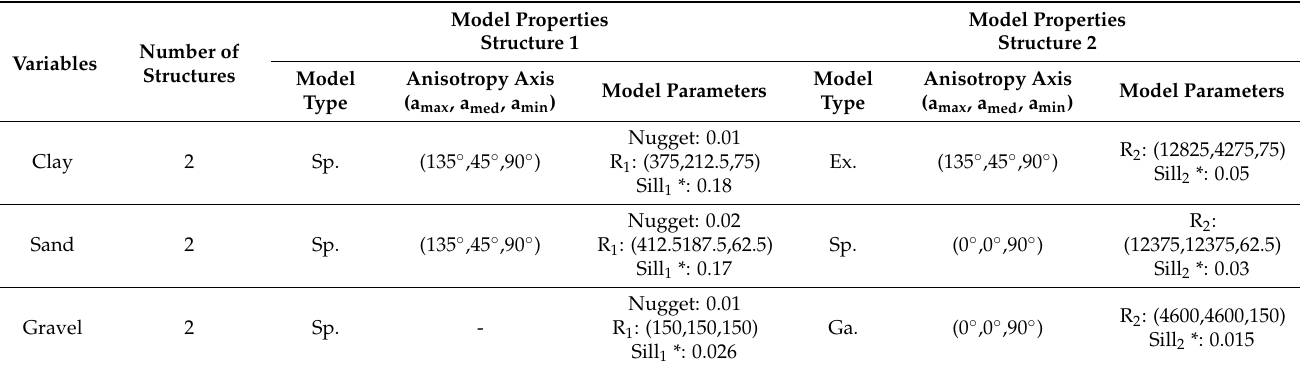
Table 2. Variogram model parameters of the soil type indicators.